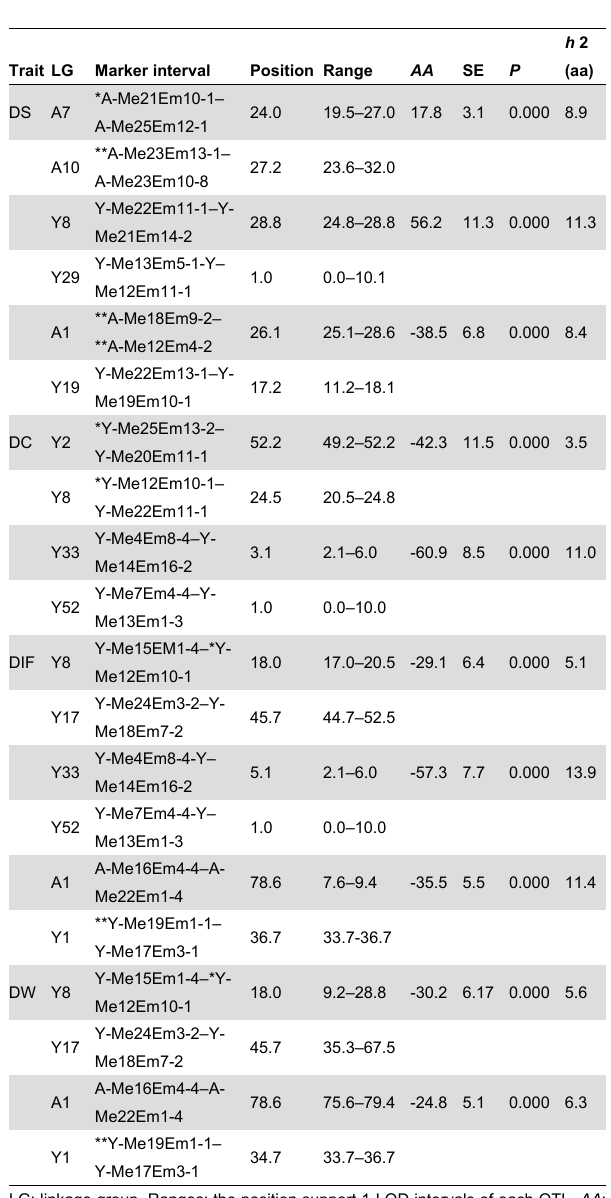
Table 4. Digenic epistatic QTL for selected flowering time